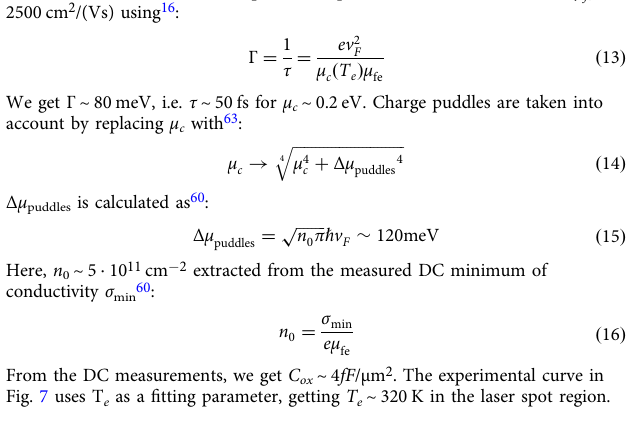
Fig. 9 Downconverted photocurrent versus gate voltage at different frequencies. The three curves show the downconverted photocurrent at 10, 21, 40 GHz. The same behavior shown in Fig. 6 is observed, regardless of the operating frequency.